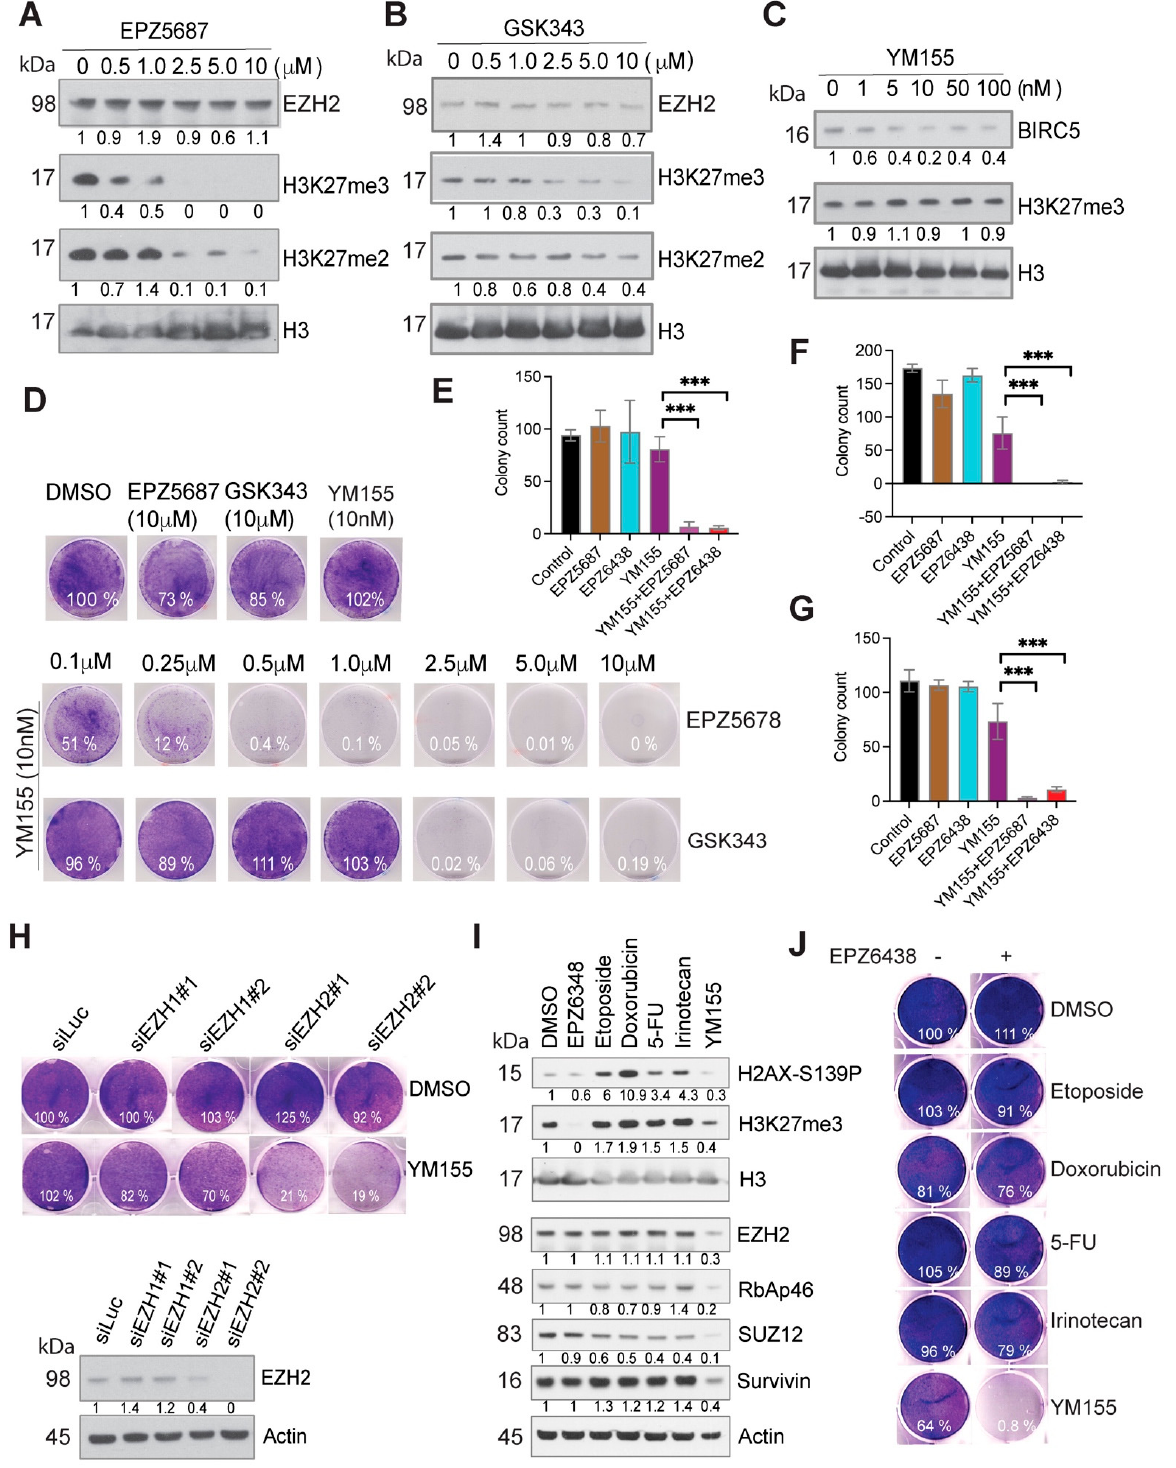
Figure 3. Synthetic lethality induced by EZH2 inhibitors and YM155. ( A – C ) Western blotting assessment of the markers with indicated antibodies. BE2C cells were treated with EZH2 inhibitor EPZ5687 ( A ), GSK343 ( B ) or BIRC5 inhibitor YM155 ( C ) with indicated concentrations for 24